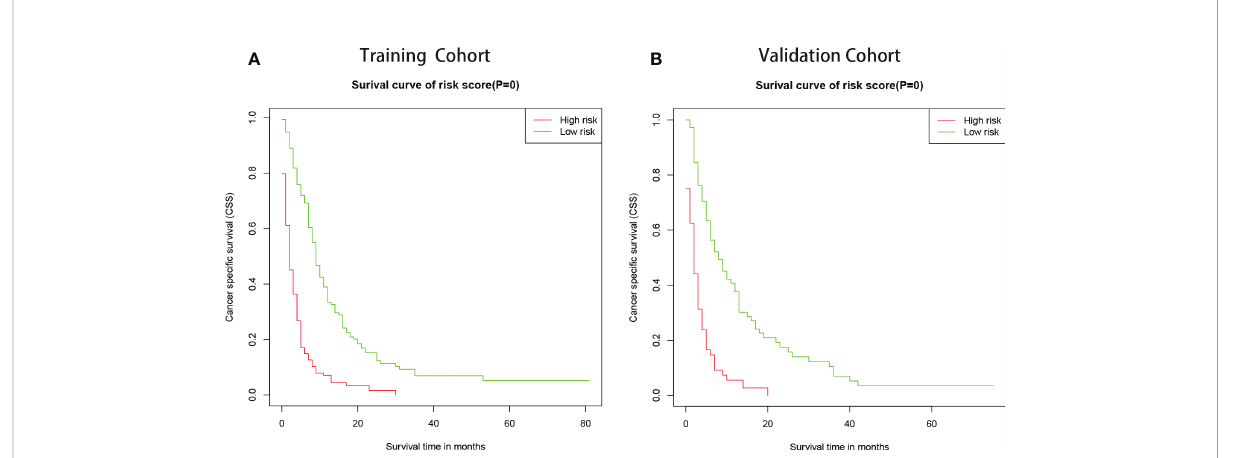
FIGURE 6 Kaplan – Meier curves of CSS for patients in the low- and high-risk groups. The patients were separated into risk-subgroups according to Cox regression model. (A) Kaplan – Meier curves of CSS according to the training cohort. (B) Kaplan – Meier CSS curves according to the validation